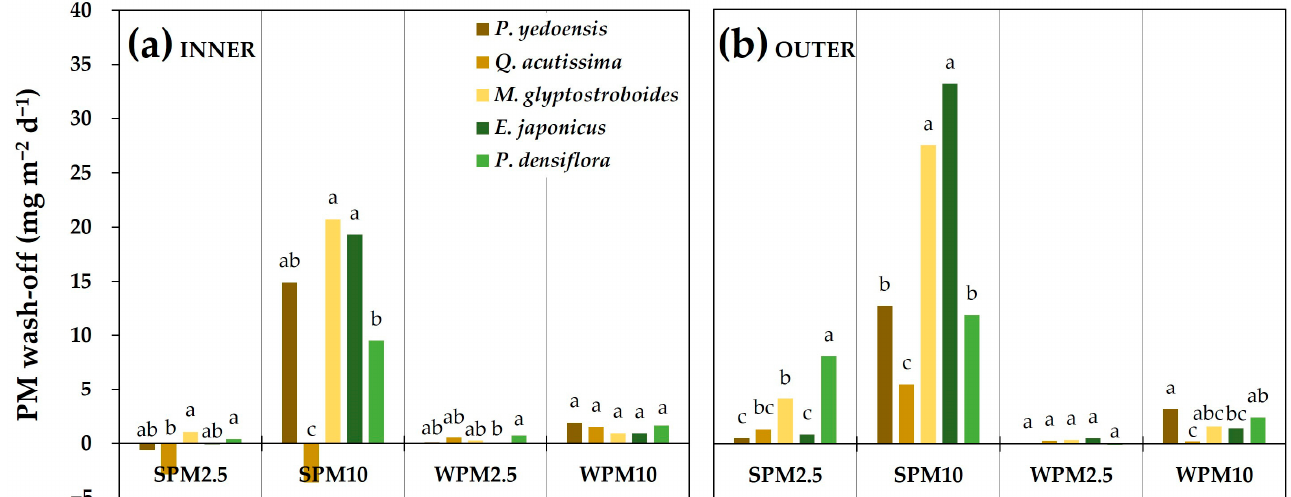
Figure 1. Net PM wash-off ability during rainfall events on surface PM (SPM2.5, SPM10) and in-wax PM (WPM2.5, WPM10) from the inner and outer crown-positioned leaves, based on the division into PM 2.5 and PM 10 fractions. ( a ) INNER, inner of individual tree crowns, ( b ) OUTER, outer of individual tree crowns. Different letters above bars represent significantly different among species in each PM particle size fraction at p ≤ 0.05 using Tukey’s HSD multiple comparisons. Data are mean, n = 5.